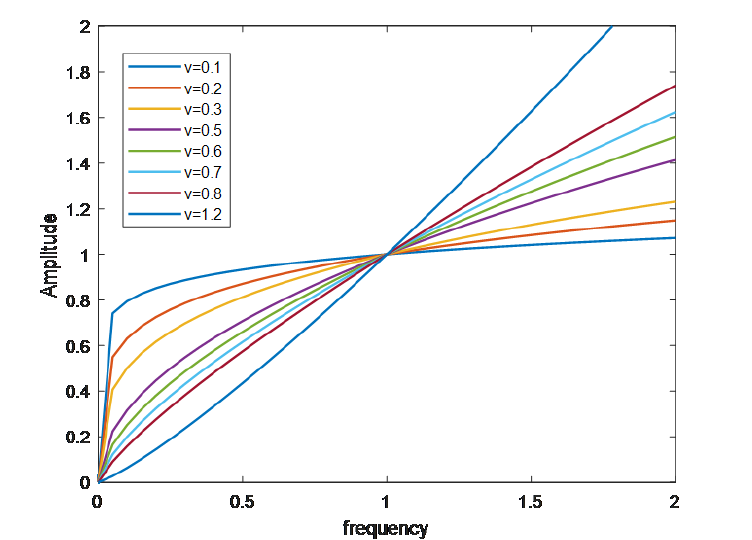
Figure 2. Amplitude frequency characteristic curve of fractional differential